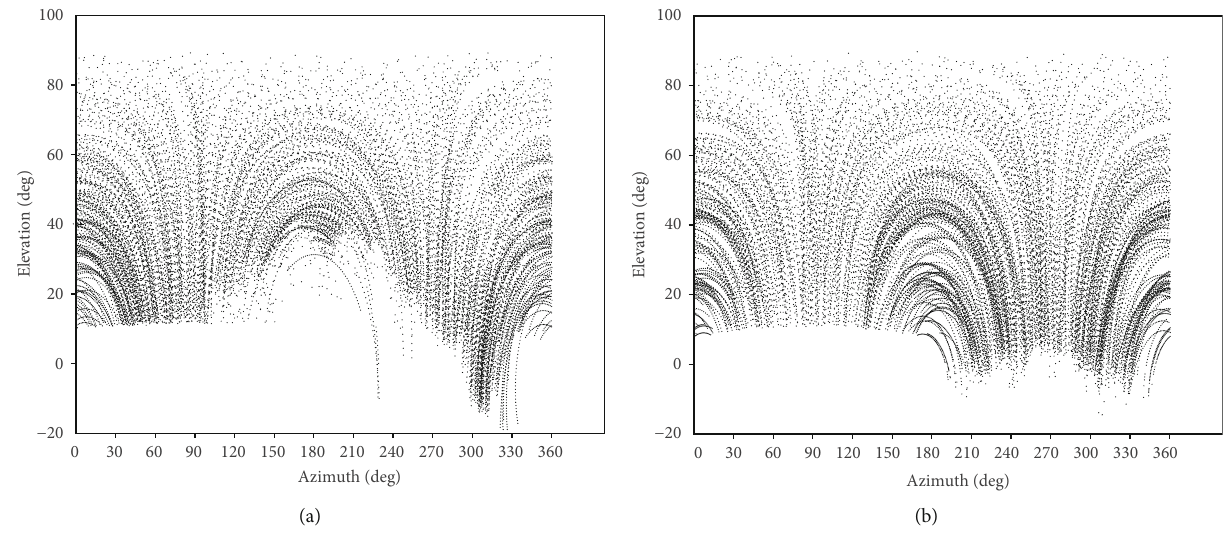
Figure 3: Azimuth-elevation maps of GPS signals for (a) KOMPSAT-5 and (b)